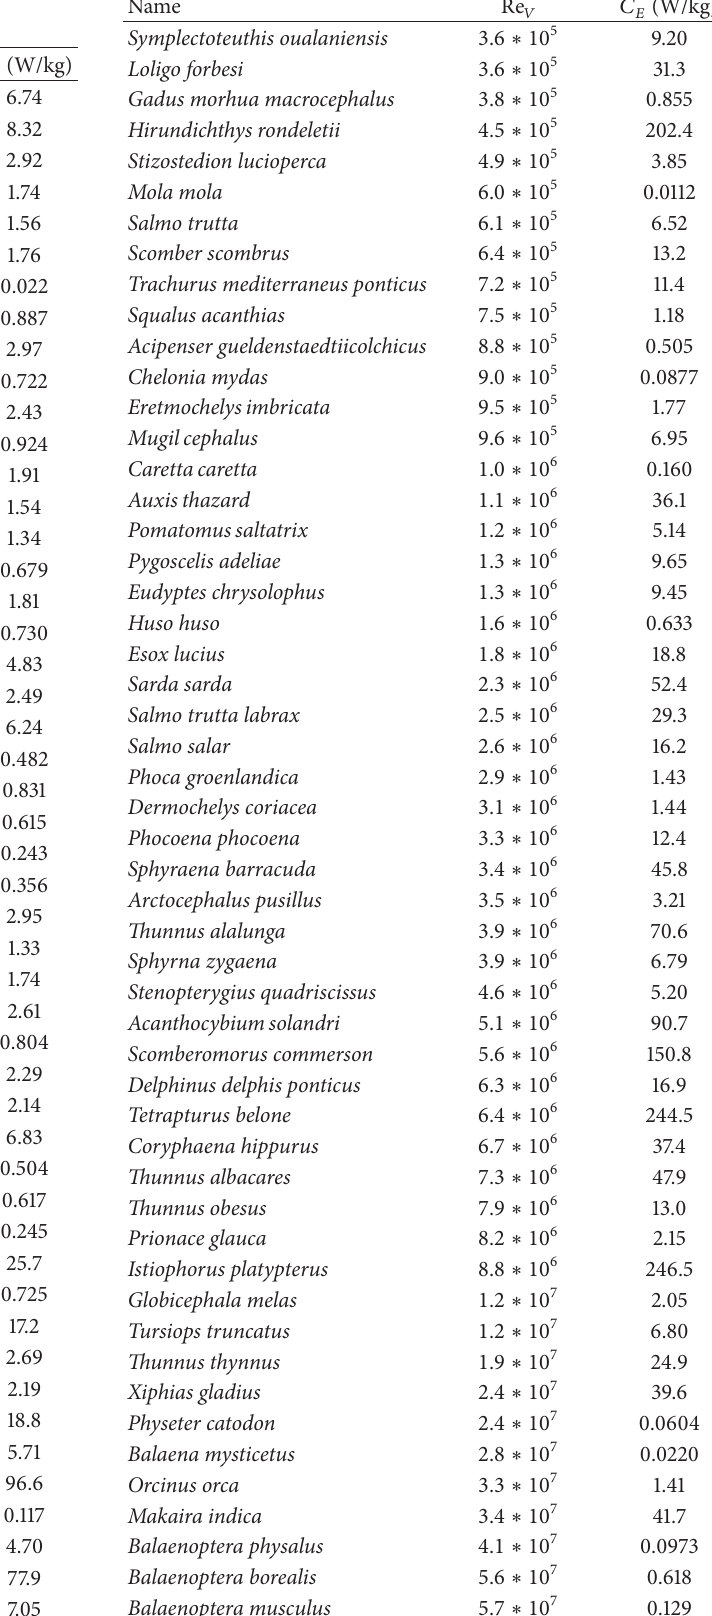
Table 1: The volumetric Reynolds number 𝑅 𝑉 and the capacity- efficiency factor 𝐶 𝐸 (W/kg) for different animals based on formula (15) and data from Aleyev